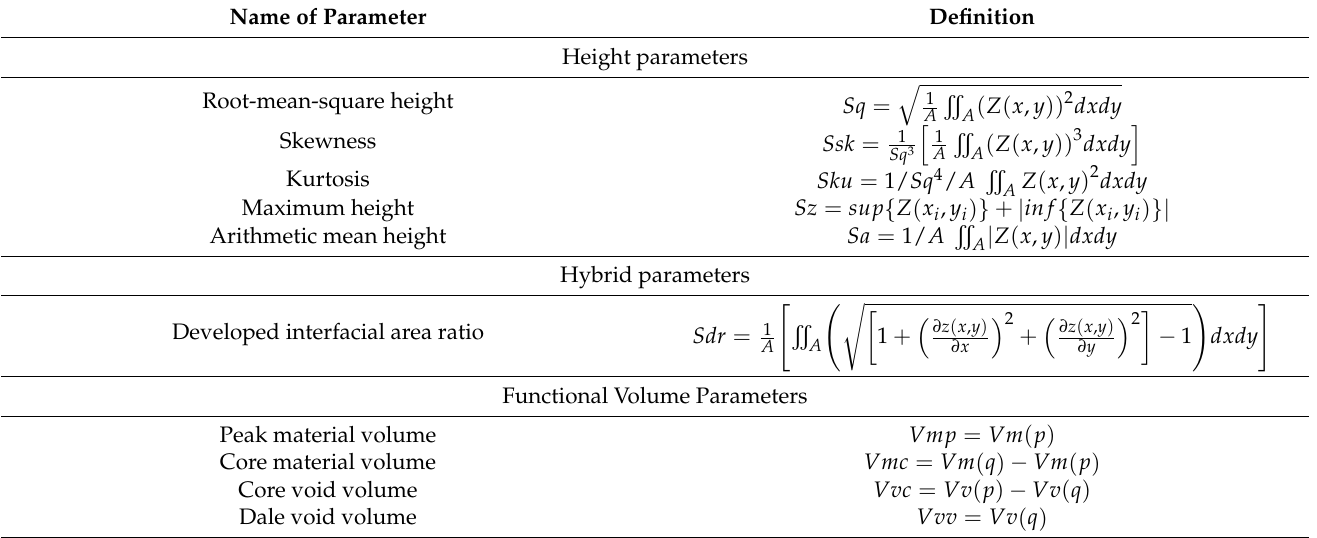
Table 1. Examples of surface parameters and their definitions according to